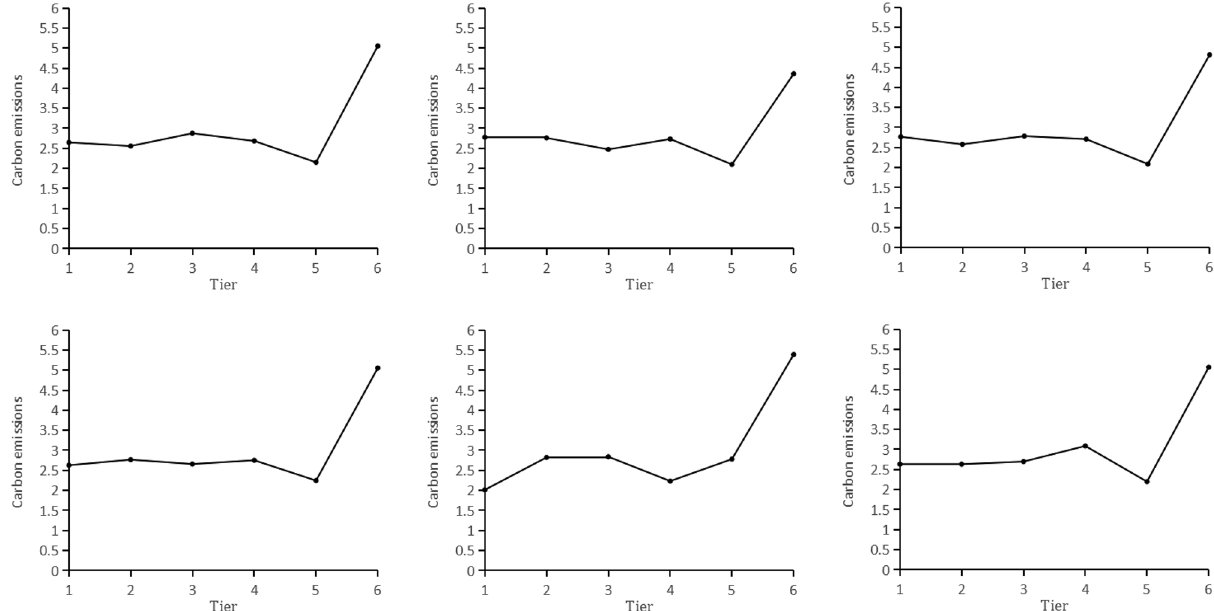
Figure 7. Risk detection